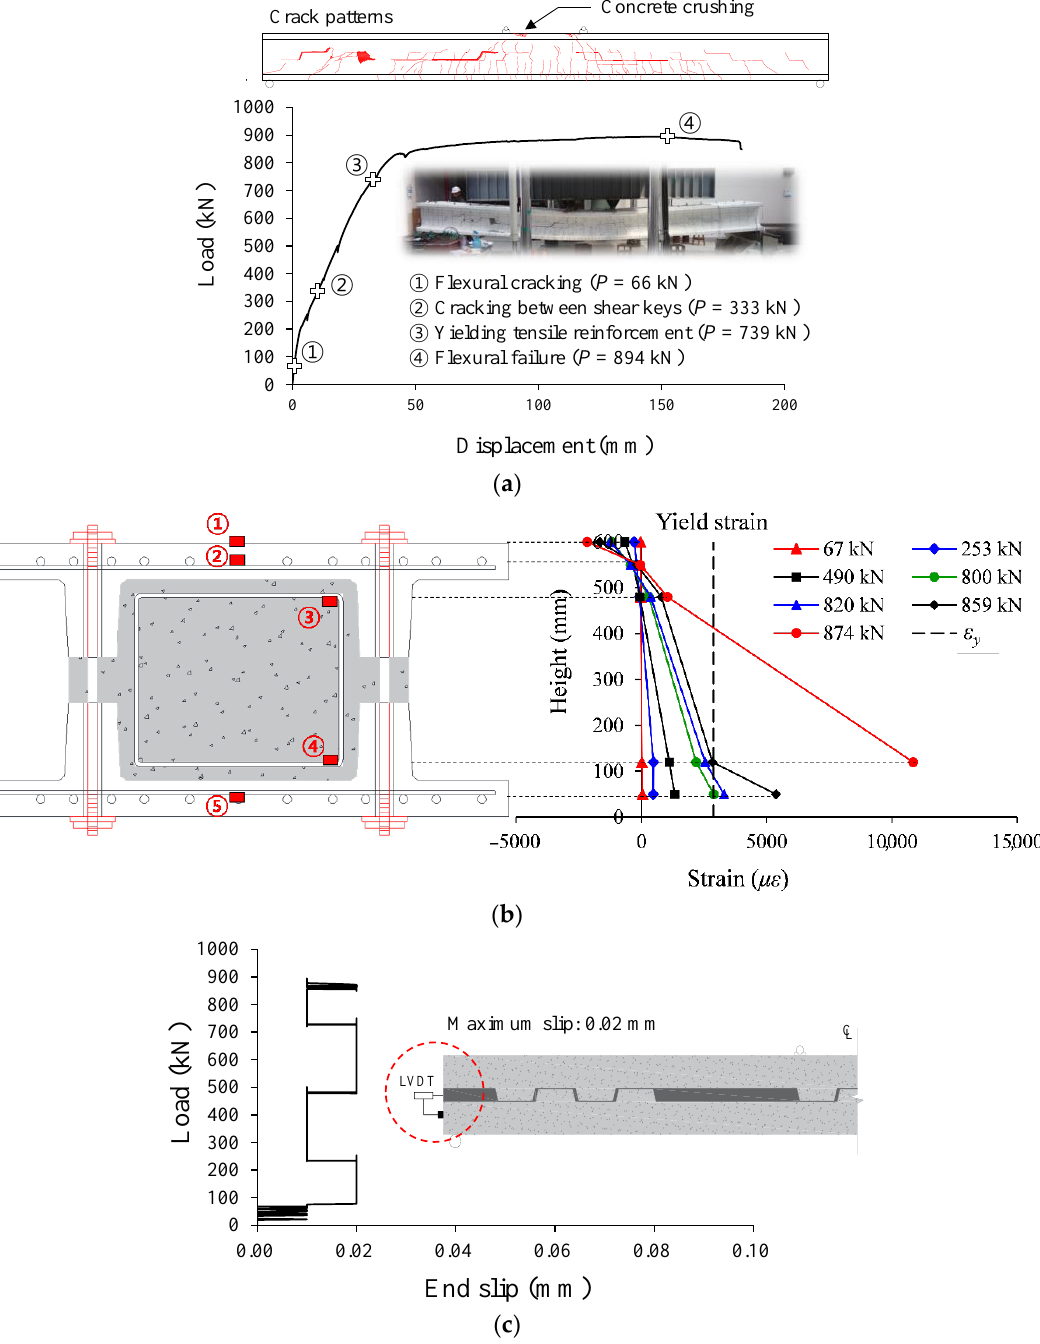
Figure 6. Flexural behavior of DCW-N specimen: ( a ) load–displacement behavior; ( b ) longitudinal strain distribution in the section at the mid-span (see Figure 5a for gauge locations); ( c ) measured end slip between the PC panel and the CIP concrete.